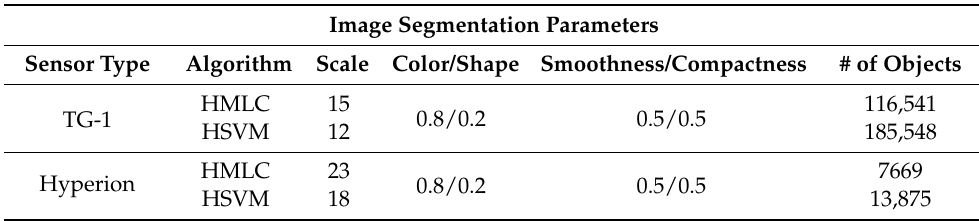
Table 3. Parameter values used in multi-resolution segmentation algorithm.